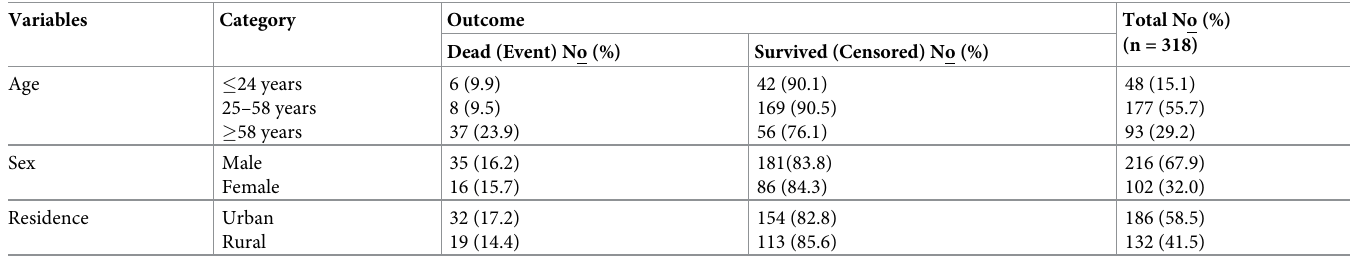
Table 1. Socio-demographic characteristics of COVID-19 cases admitted to Wollega University Referral Hospital, Western Ethiopia.